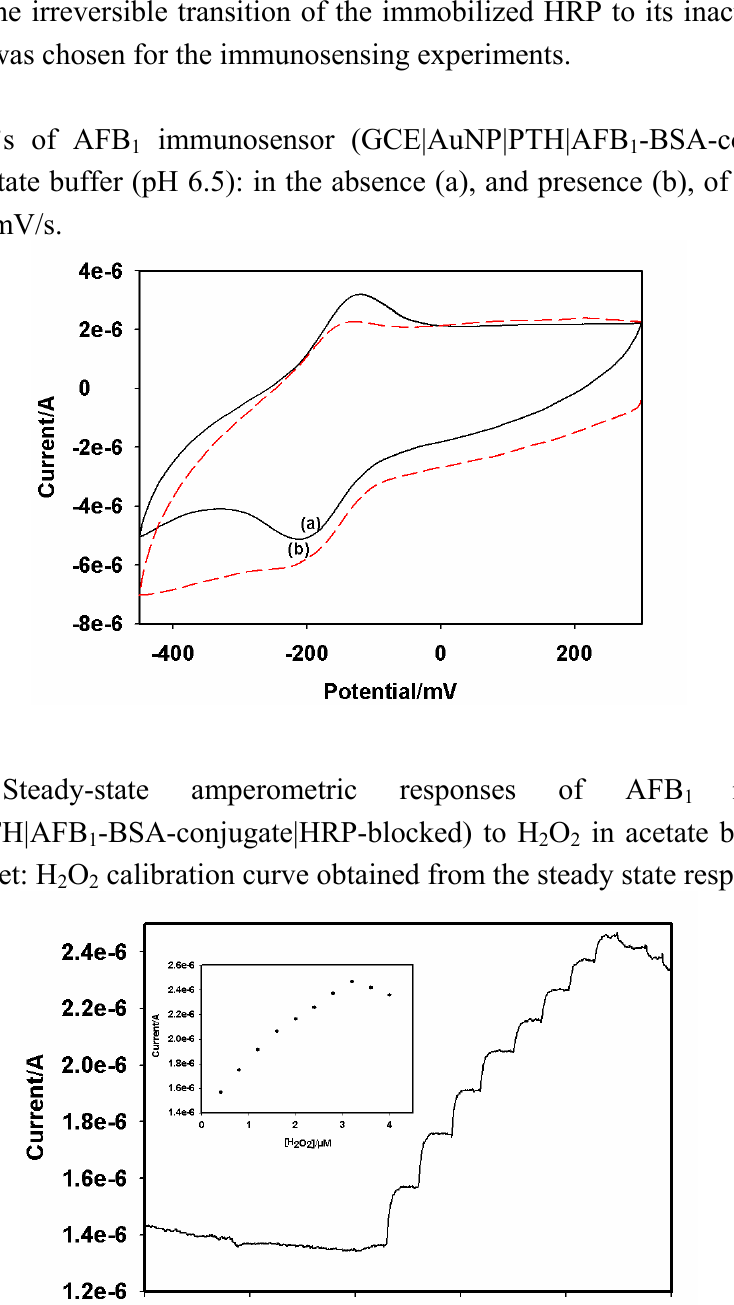
immunosensor (GCE|AuNP|PTH|AFB 1